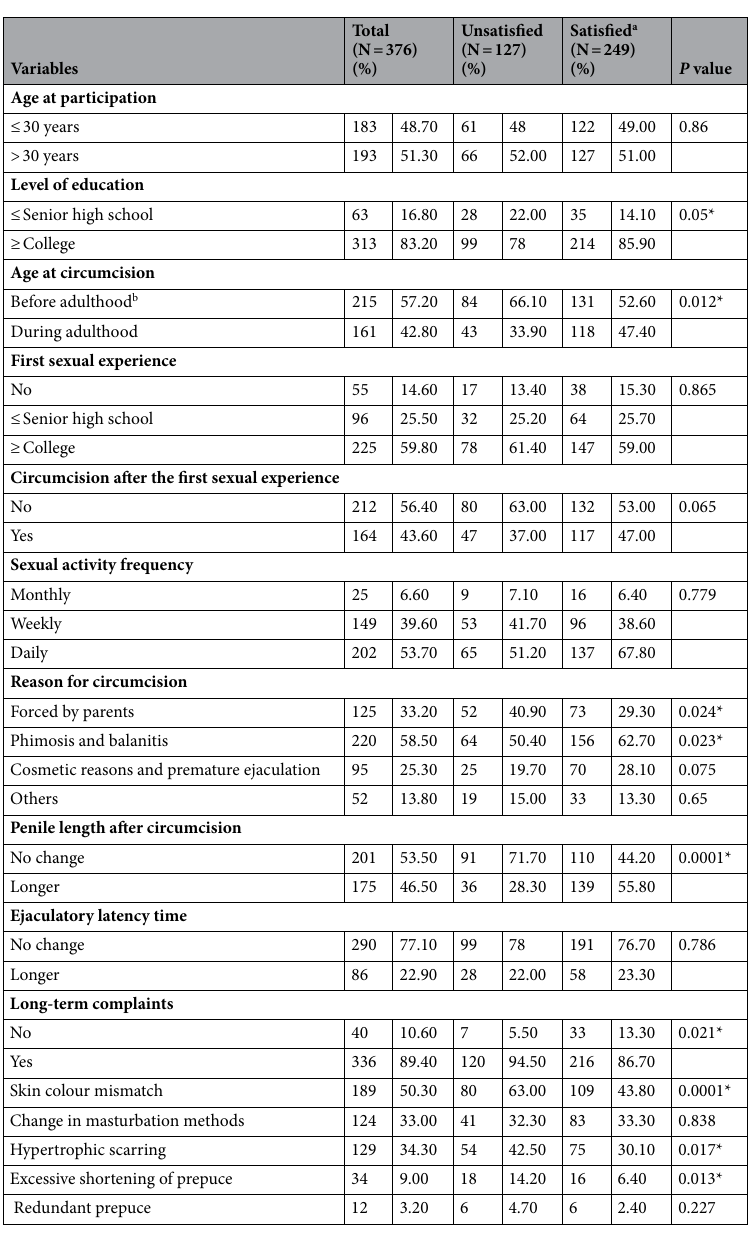
Table 1. Demographic data of factors influencing satisfaction. Chi-square test calculated for the difference in variables for satisfaction. * P < 0.05. a Visual analogue scale score ≥ 6 (range,1–10) is defined as satisfied. b Adulthood means over 20 years